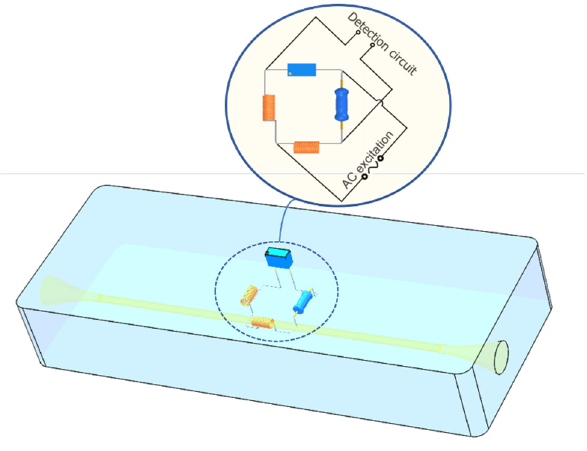
Figure 1. Schematic diagram of microfluidic chip sensing unit.